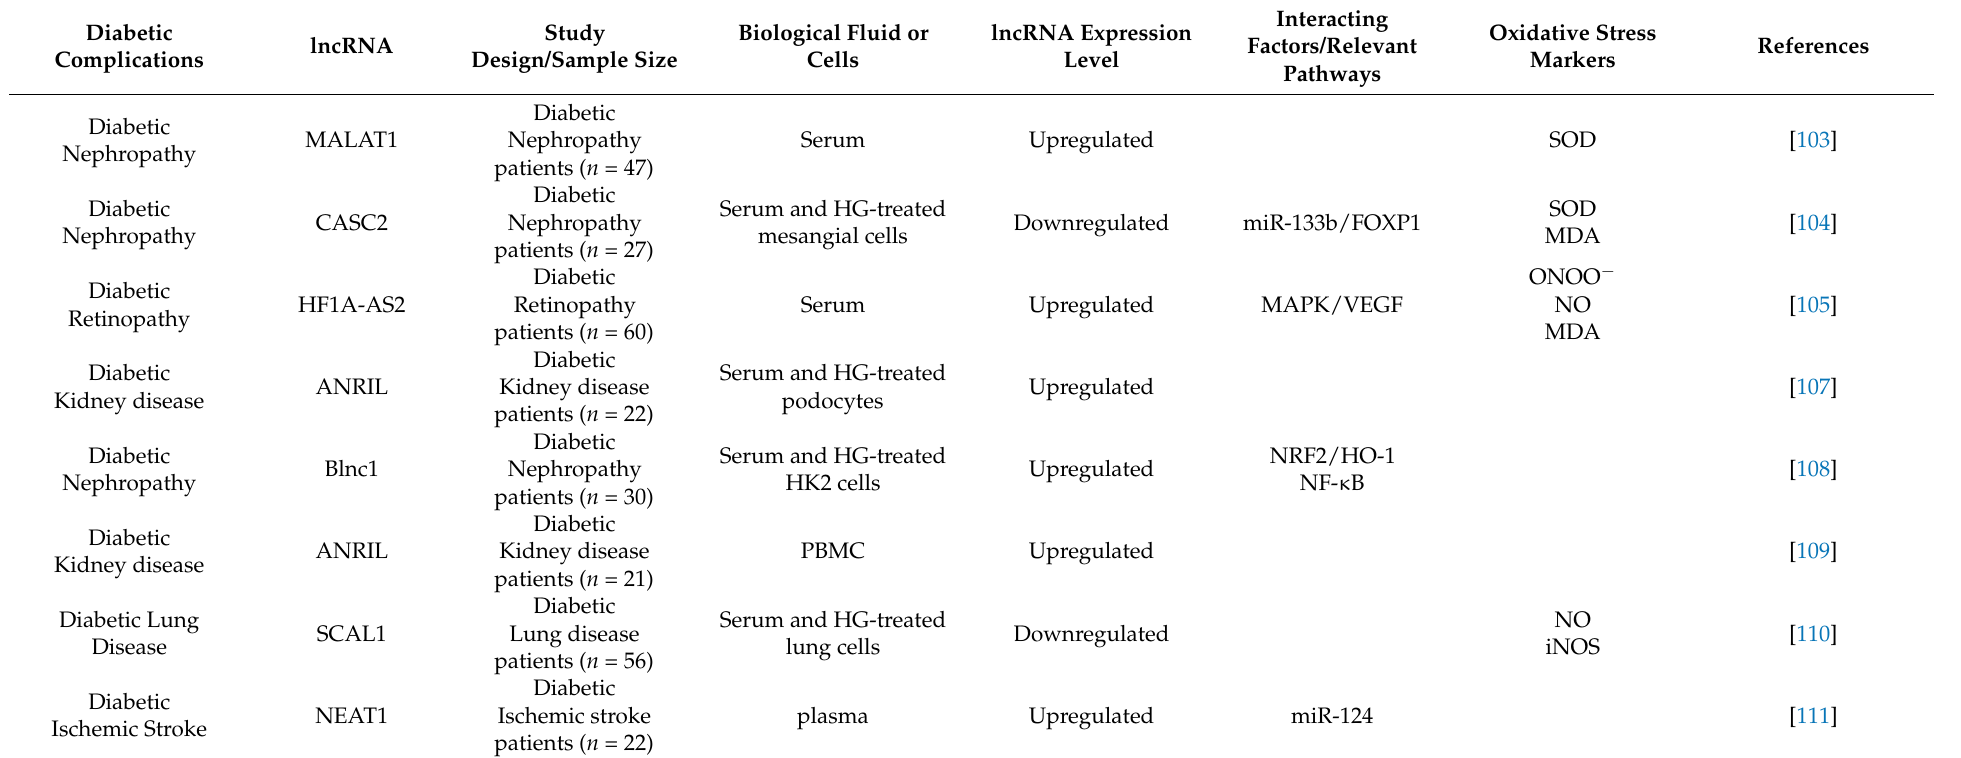
Table 1. lncRNAs implicated in the pathogenesis of oxidative stress in different diabetic